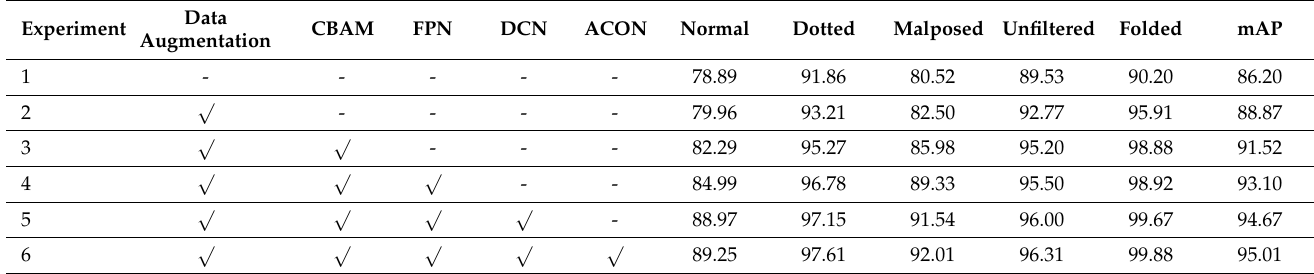
Table 5. AP comparison of adding different modules %.